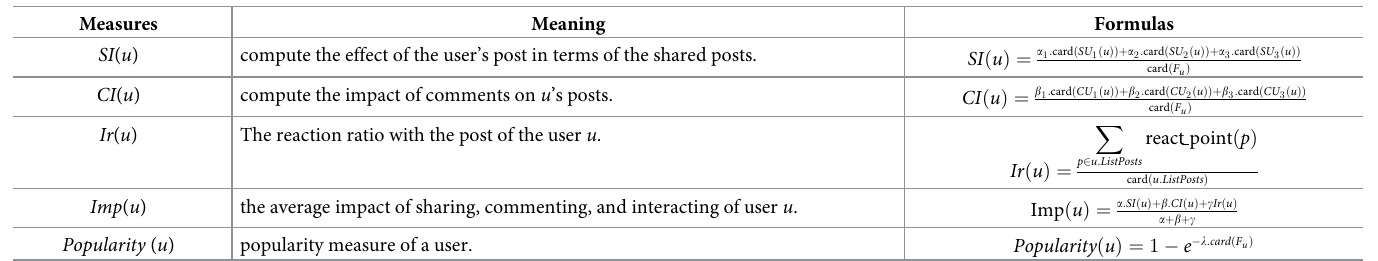
the average impact of sharing, commenting, and interacting of user u